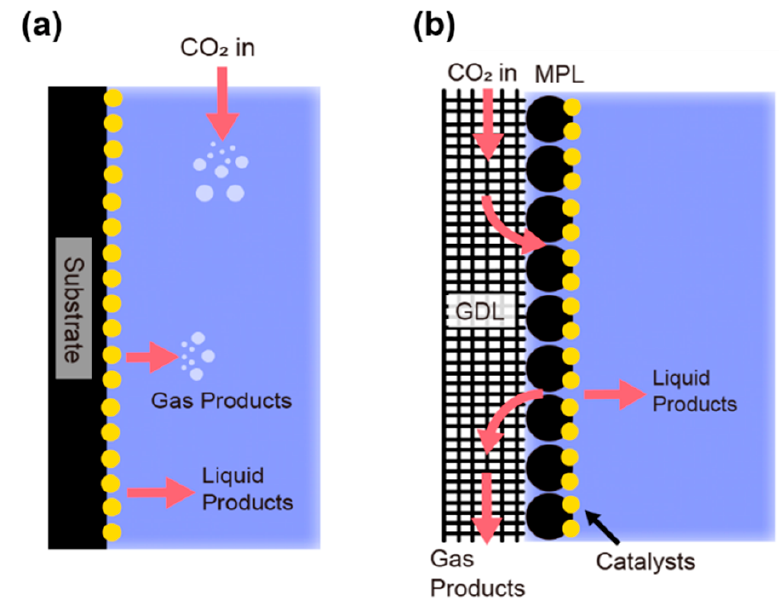
Figure 3. Schematics comparing the concept of ( a ) liquid-phase and ( b ) gas-phase CO 2 reduction reactions.